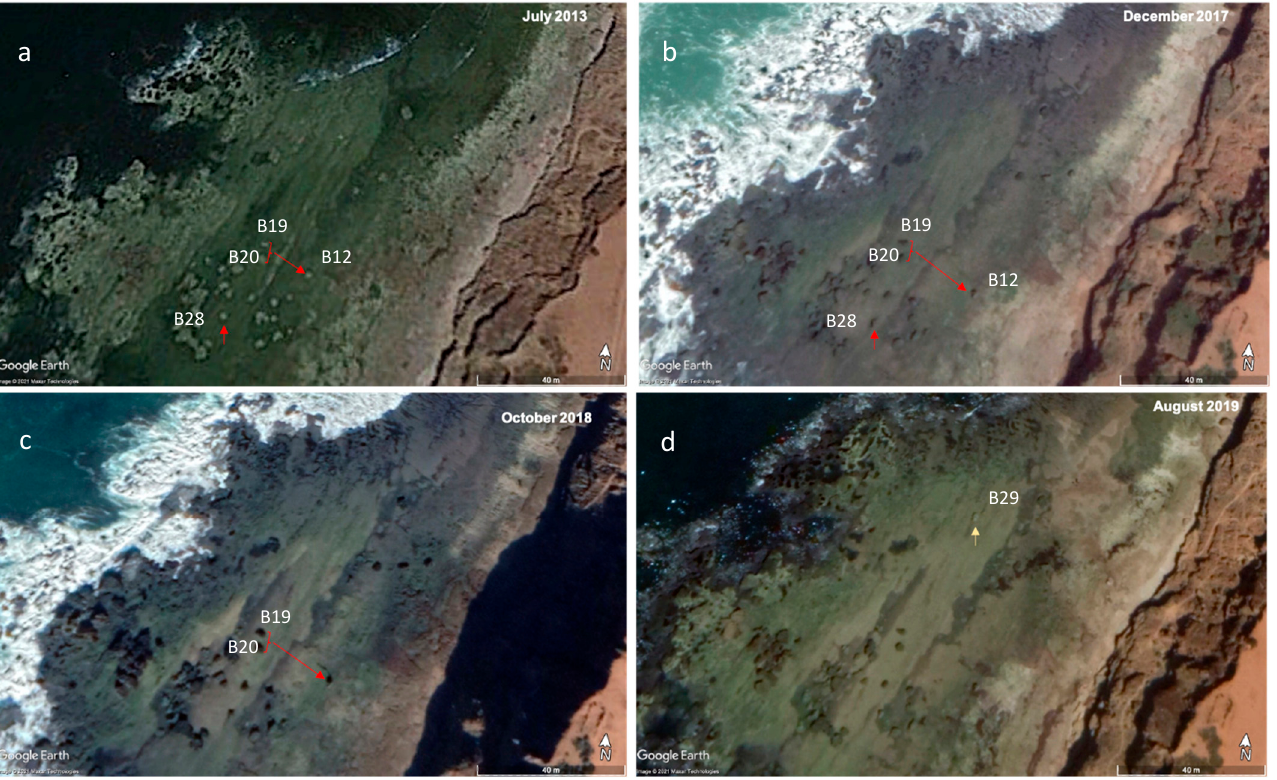
Figure 15. Satellite images (Google Earth Engine) of Laghdira in 2013, 2017, 2018, and 2019: ( a ) po- sitions of boulders B12, B19, B20, and B28 in 2013; ( b ) displacement of boulders B12 and B28 between 2013 and 2017; ( c ) no significant and detectable changes in boulder locations in 2018; ( d ) appearance of boulder B29 on the rock platform of the study site in 2019.